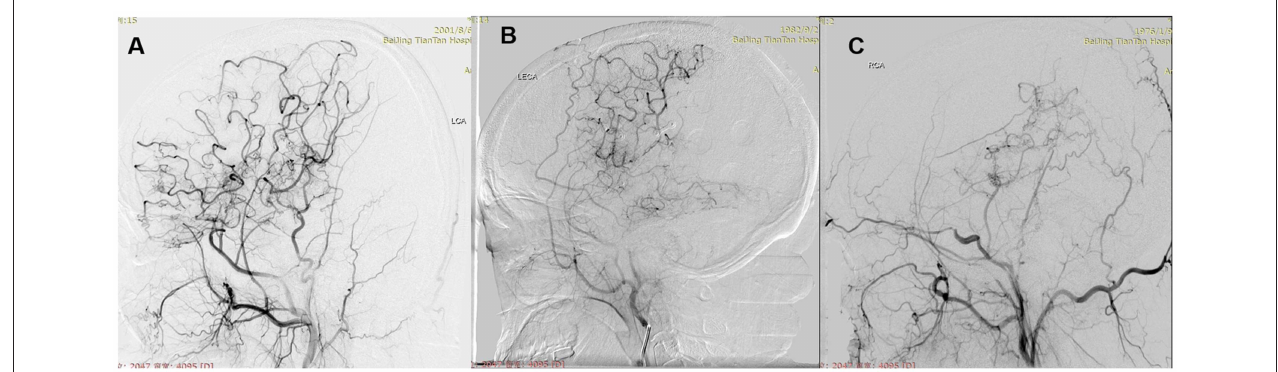
FIGURE 3 | Postoperative collateral formation was evaluated with the Matsushima scale. (A) Level A: more than 2/3 of the MCA distribution. (B) Level B: between 2/3 and 1/3 of the MCA distribution. (C) Level C: slight or none.